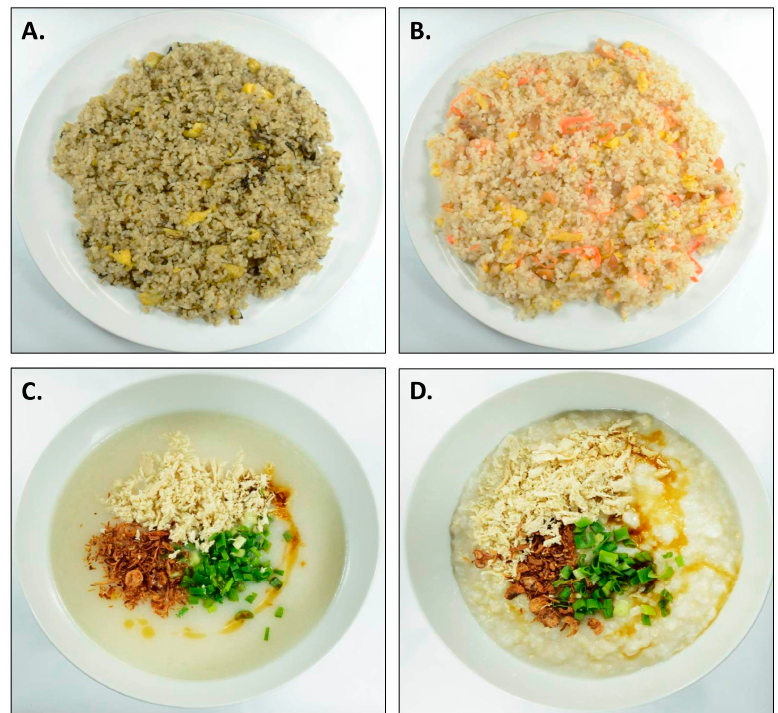
Figure 1. The four test meals consumed in each study. ( A ) Participants in Study 1 consumed olive fried rice; ( B ) Participants in Studies 2 and 3 consumed Yang Chow fried rice; Participants in Study 4 consumed ( C ) thin and ( D ) thick chicken rice porridge varying in energy density.